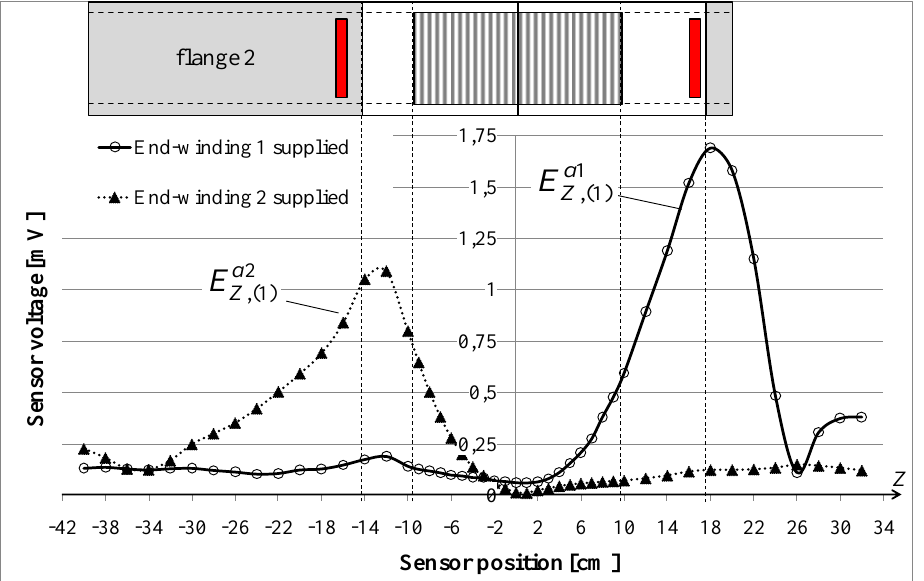
Figure 7. Measurement of the axial field component along the Z axis: variations of a a E and 2 E sensor fundamental voltages obtained with the artificial the 1 )1(, Z )1(, Z